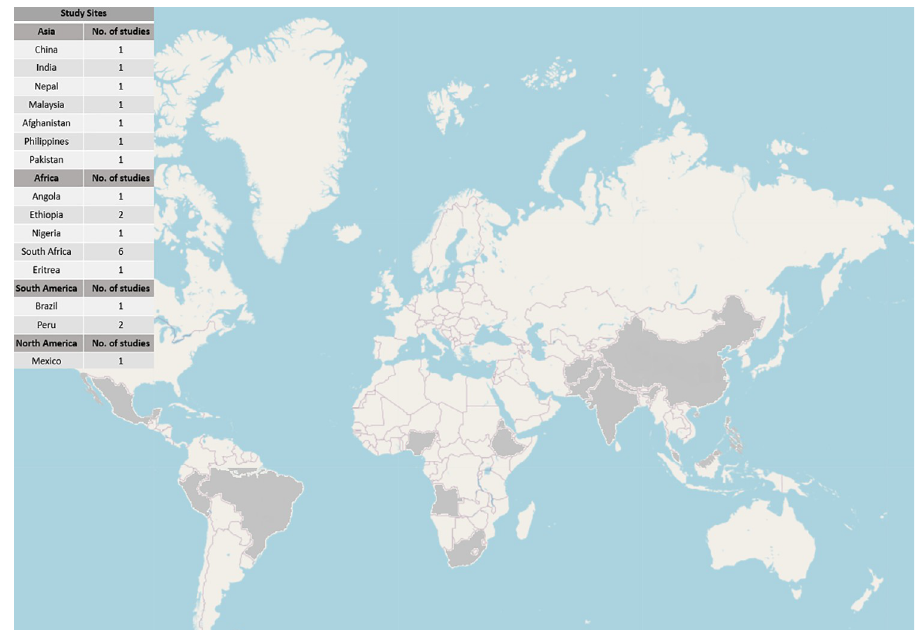
Fig 2. Map of study sites. Map shows the countries and the respective number of studies conducted in each country. The base layer of the map is taken from http://www.openstreetmap.org.